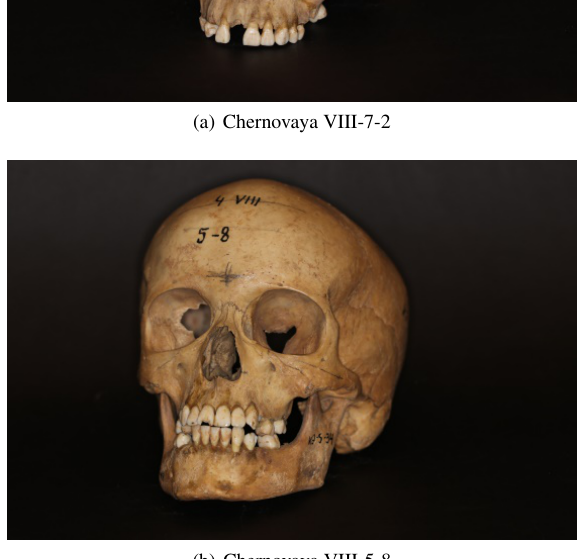
Figure 1. Skulls VIII-7-2 (a) and VIII-5-8 (b), Chernovaya. Our first attempt for shade matching by two different spectropho- tometric devices: Vita EasyShade (Vita Zahnfabrik) and Spec- troShade (MHT) brought to inconsistent results, which are pre- sented according to two standard shade-guides: Vita Classic and